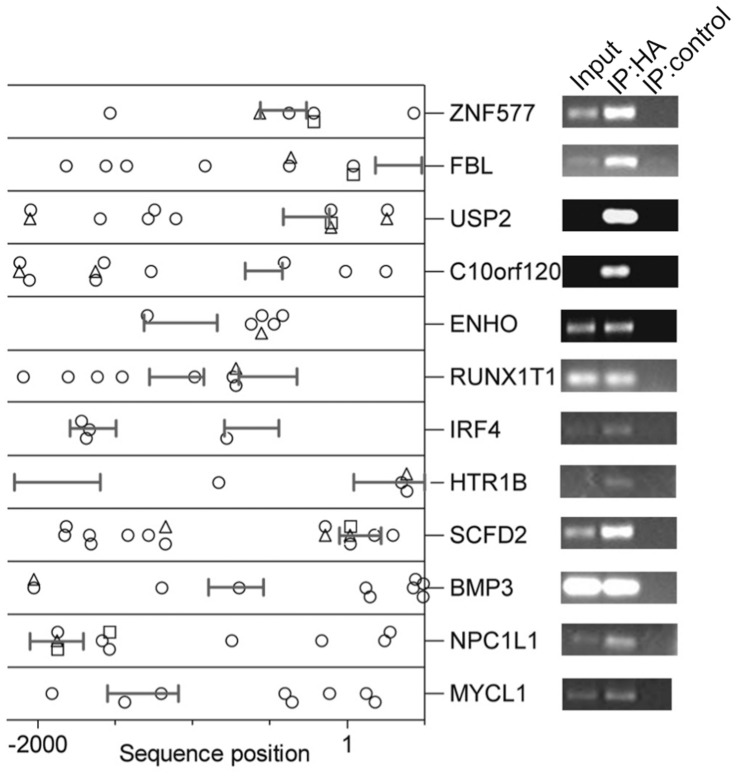
Identity of MXD3 direct target genes.MXD3 direct target genes from ChIP-chip analysis were validated by PCR on an independent ChIP sample. Specific bands are shown in the panels on the right. Transcription factor binding prediction analysis indicated the presence of E-boxes of the c-Myc (○), Max (▵) and N-Myc (□) type. Symbols represent the position of the predicted binding site, relative to the transcription start site. The position of the peak for MXD3 binding, as determined by Maxfour analysis of ChIP data, is indicated by a line (|–|).